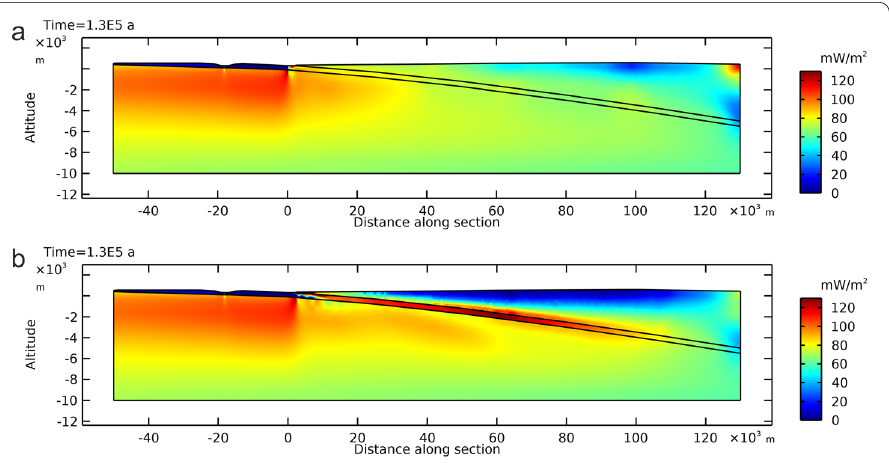
Fig. 12 Vertical component of the conductive heat flow density at present (time paleoclimatic conditions in a the low Malm permeability scenario (i.e. model run D introduced in Fig. 3), and b the high Malm permeability scenario (i.e. model run E). Vertical exaggeration equals